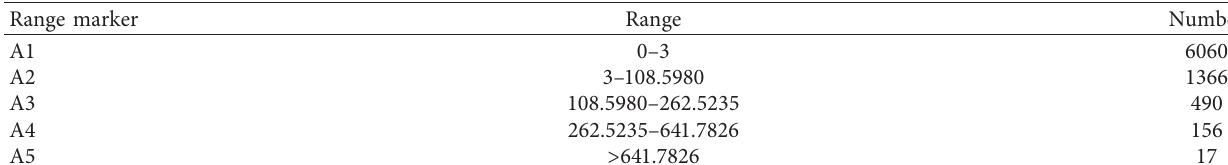
Table 4: The discrete number of dining facilities.